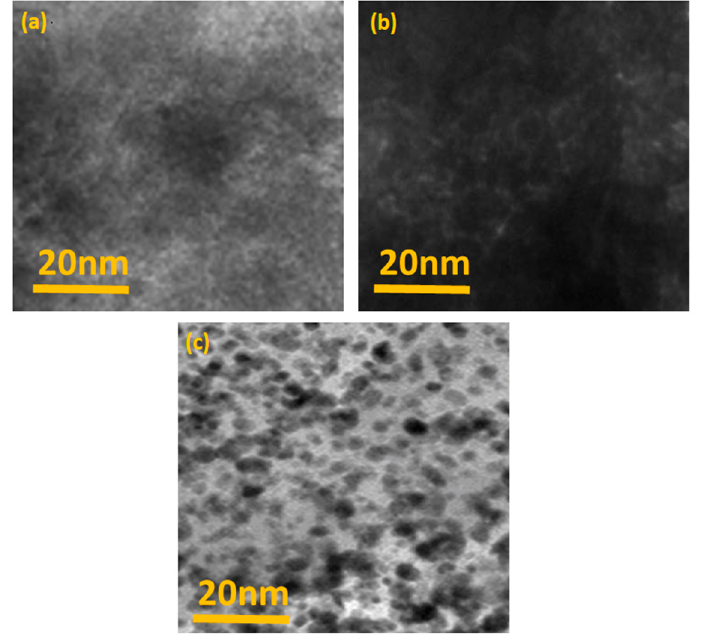
Figure 5. TEM images of ( a ) HMMT, ( b ) PANI–HMMT and ( c )